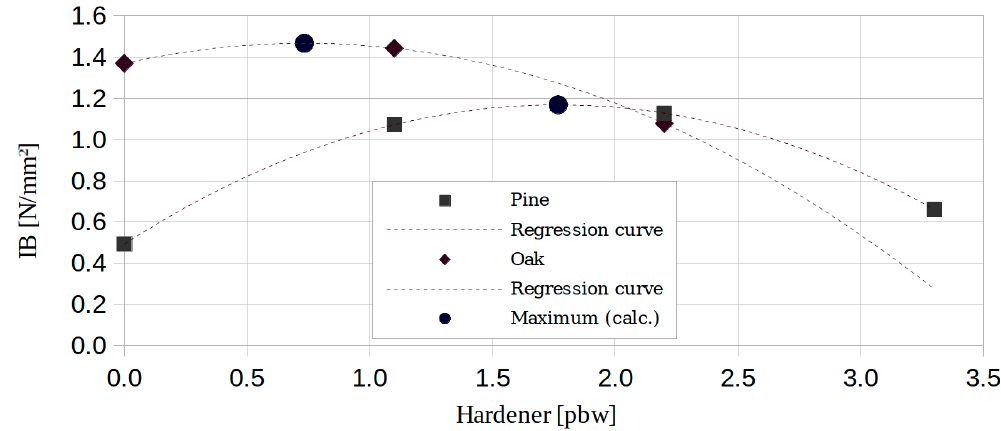
Table 3. Sample appearance of the boards made of pine.